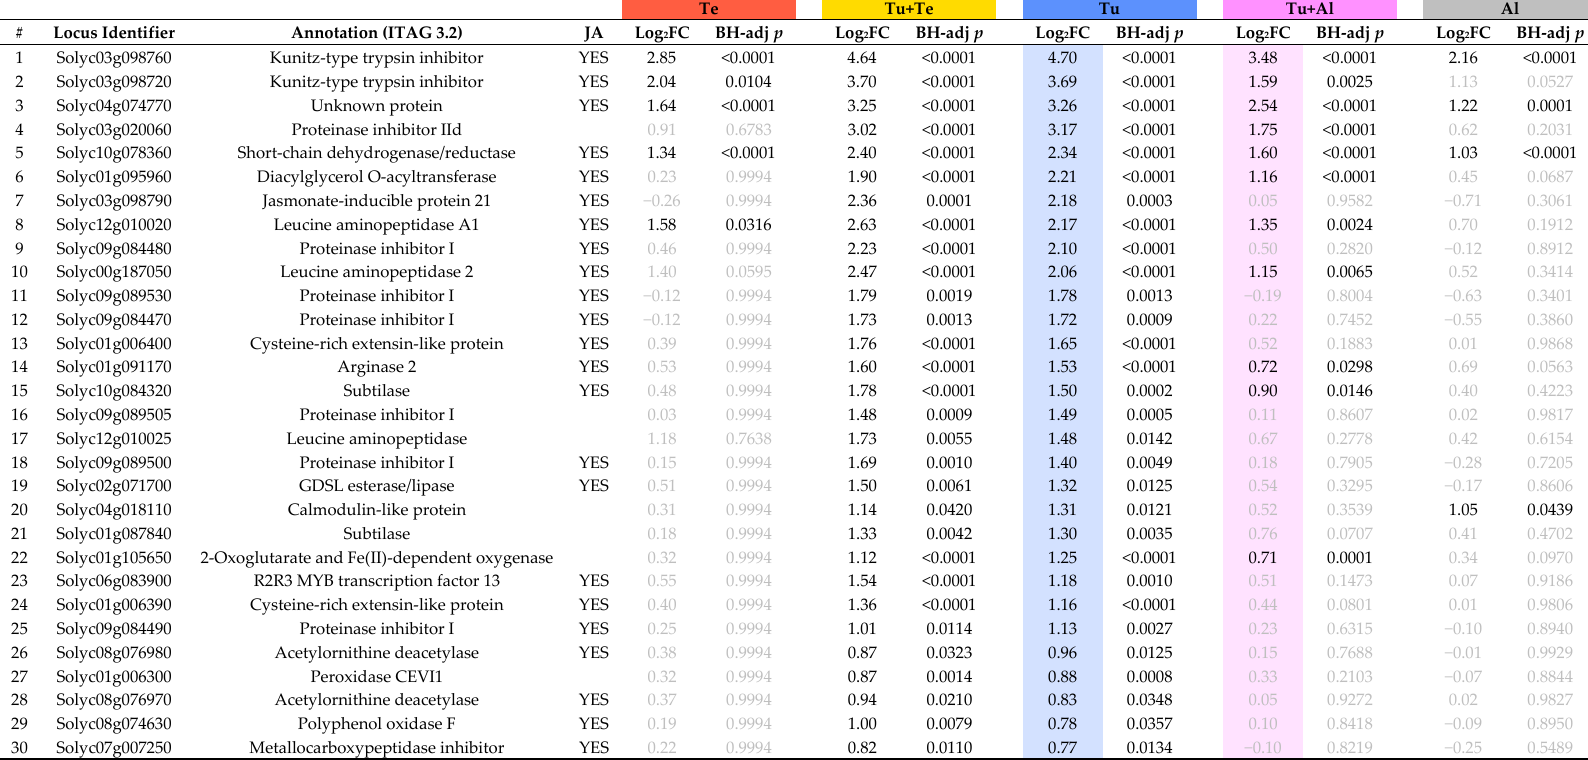
Table 1. List of candidate tomato ( Solanum lycopersicum ) genes whose expression may be suppressed by Aculops lycopersici , i.e., relative to full induction by Tetranychus urticae . Shown are Log 2 fold change (Log 2 FC) values of tomato genes upon infestation with either a single mite species ( T. urticae (Tu), T. evansi (Te), or A. lycopersici (Al)) or two species simultaneously ( T. urticae plus T. evansi (Tu+Te), or T. urticae plus A. lycopersici (Tu+Al)) as compared to non-infested controls, along with their corresponding Benjamini and Hochberg false discovery rate adjusted p values (BH-adj p ). Information in the column with header “JA” indicates whether expression of the respective gene was found to be significantly induced in the tomato JA-biosynthesis mutant def-1 , 24 h after exogenous application of JA (for details see [39]). Candidate genes were selected based on two criteria: (1) expression is up-regulated (BH-adj p ≤ 0.05) in the Tu sample, while; (2) in the Tu+Al sample such up-regulation is considerably lower (Log 2 FC in Tu (shaded blue) − Log 2 FC in Tu+Al (shaded lilac) > 0.5) or absent. Selected genes were ranked according to their relative expression level in the Tu sample. Grey letters indicate a non-significant (BH-adjusted p > 0.05) change in gene expression. Te Tu+Te Tu Tu+Al Al # Locus Identifier Annotation (ITAG 3.2)